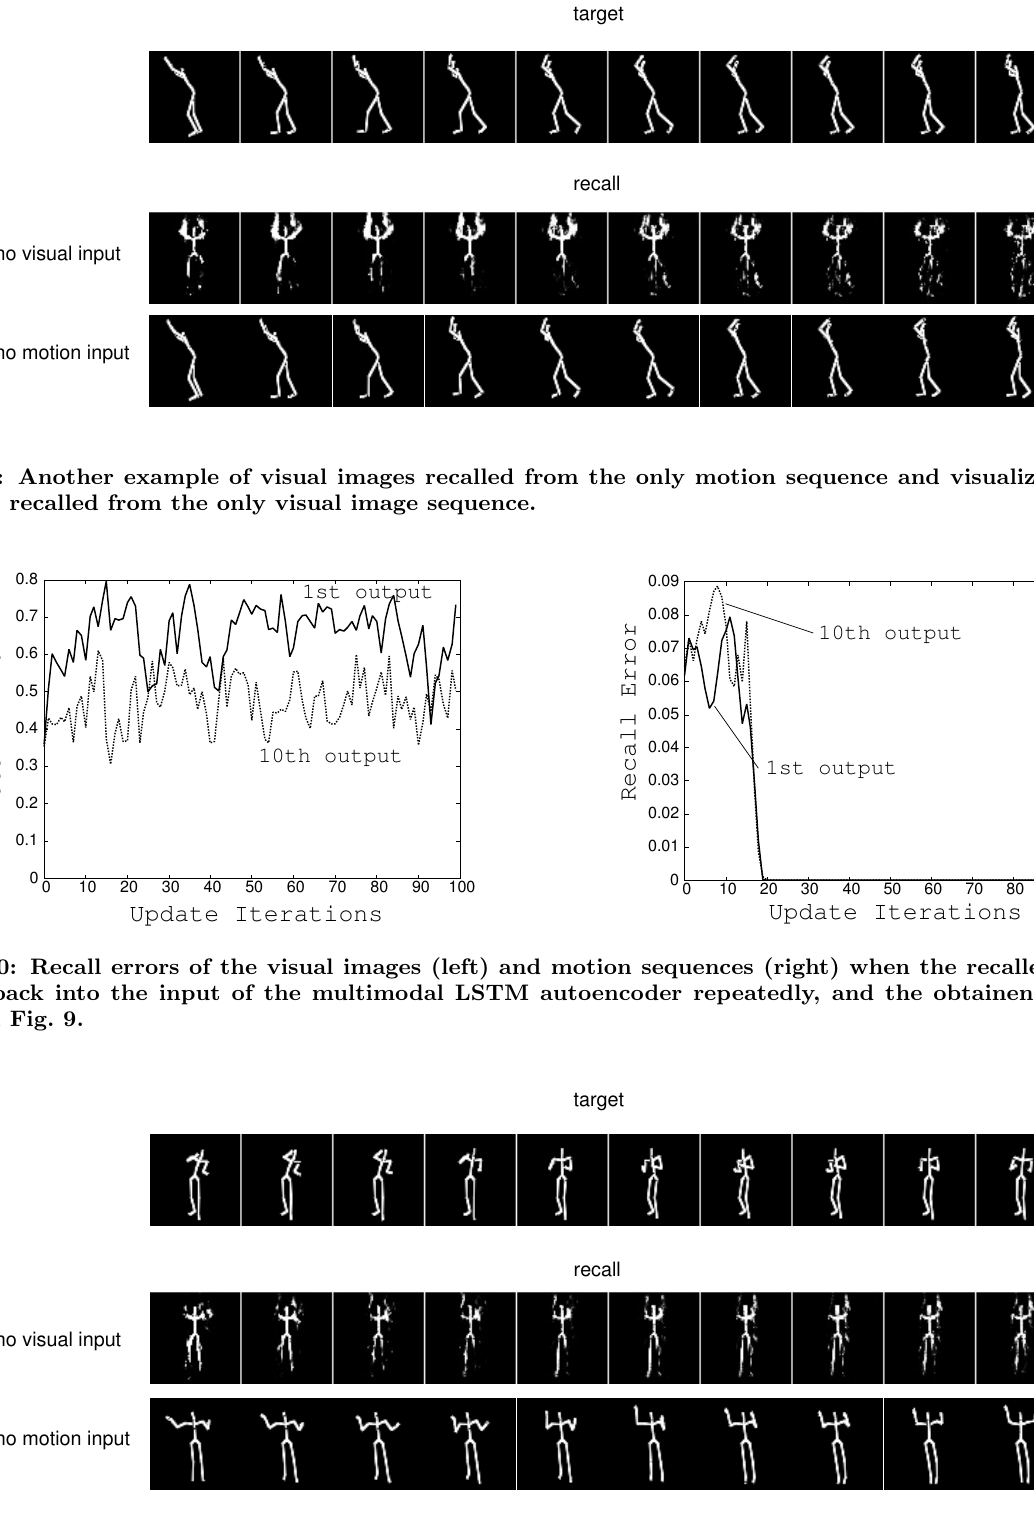
Figure 11: Visual images recalled from the only motion sequences and visualized motion sequences recalled from the only visual images. The input and target is not used to train the model. The rotation of motion pattern is set to that of target to clarify the motion of